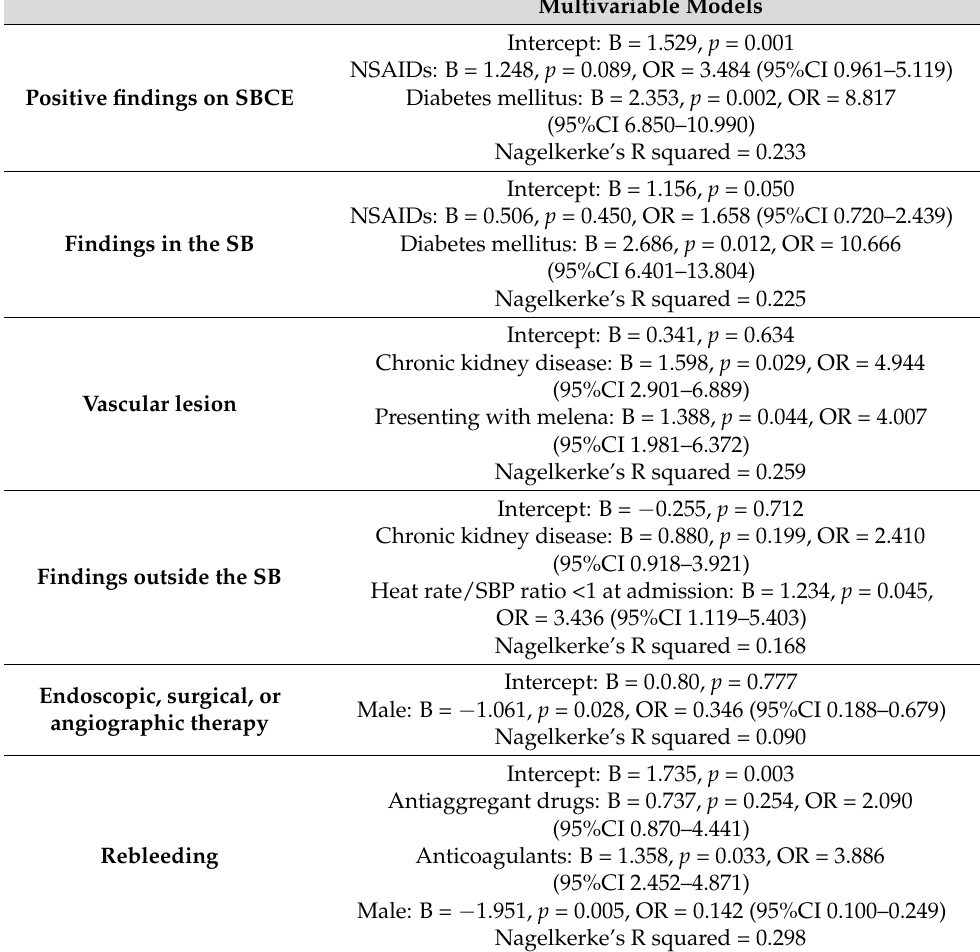
Table 3. Final models with predictive factors for the detection of positive findings, need for endoscopic or surgical therapy, and rebleeding (multivariable